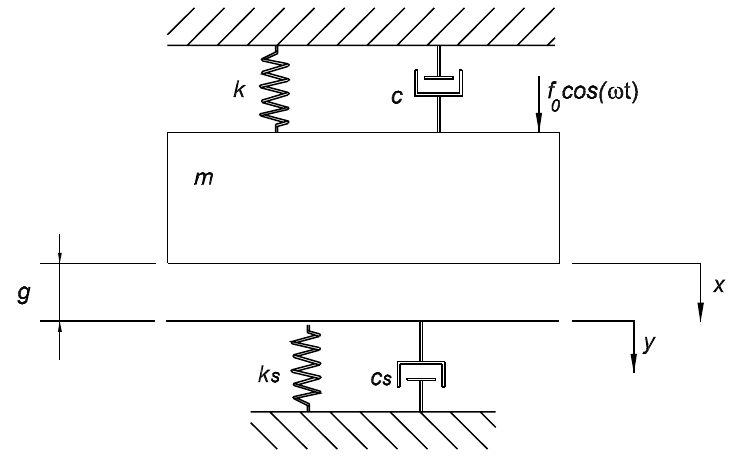
Fig. 1. Non-smooth system with discontinuous